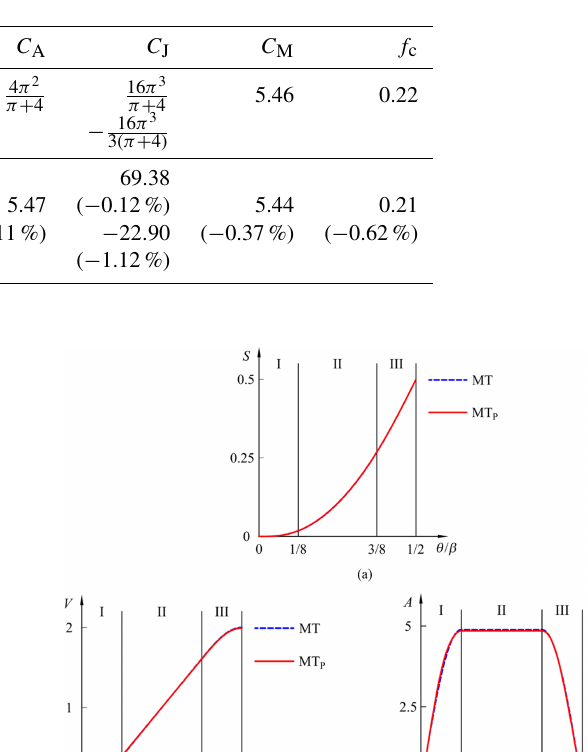
Table 3. Motion characteristics of MS P and MS.